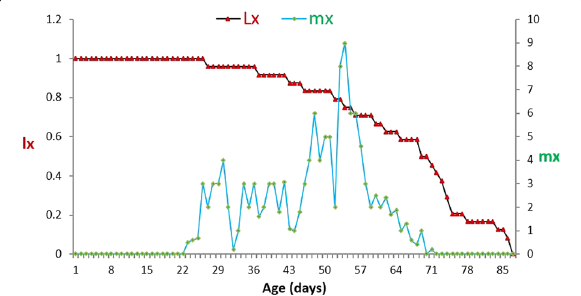
Fig. 1 Age specific survival ( l x ) and fertility ( m x ) of adult female H. dimidiata fed on R. padi aphid at 16